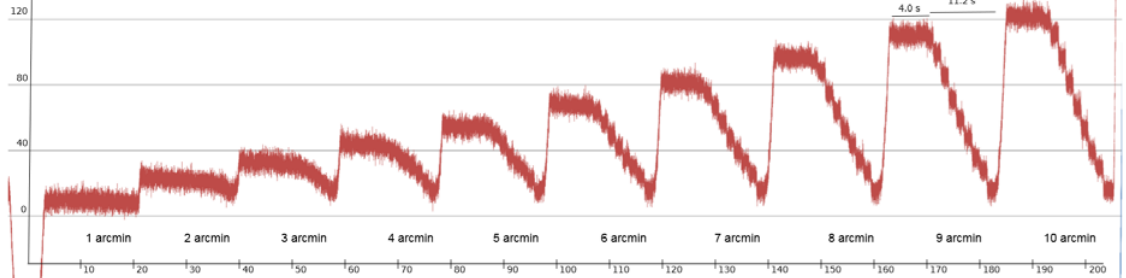
Figure 1. Increasingly larger steps from 1 arcmin to 10 arcmin steps. Each staircase shape involved 10 movements of identical amplitude after a 4 s waiting period. Stops between steps are 1 s long. The smaller movements clearly drown in the noise of this Tobii TX300 eye tracker, and resolution is 6‐7